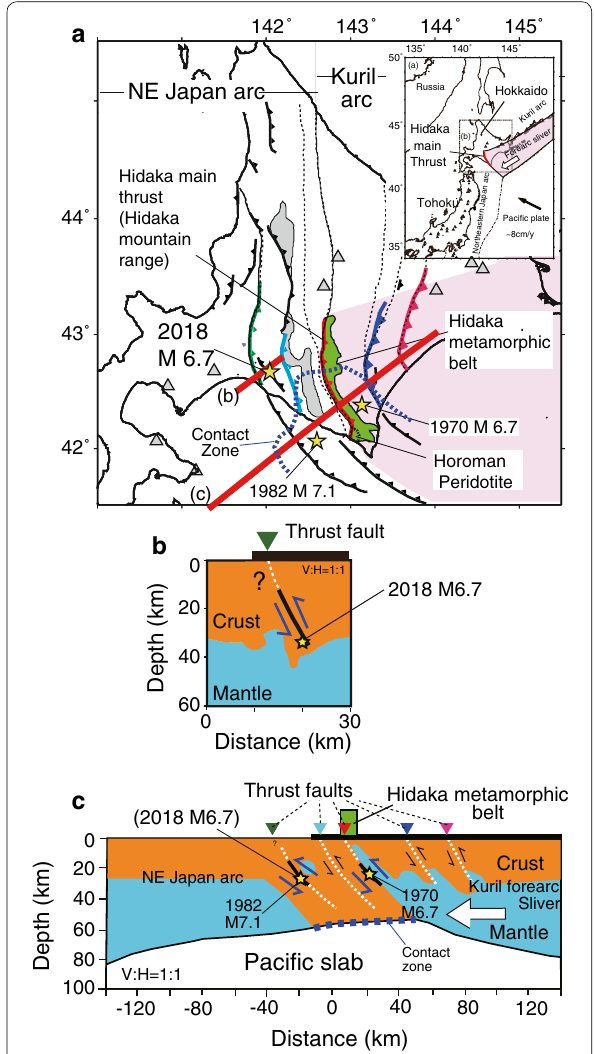
Fig. 1 a Tectonic setting of Hokkaido (modified after Kita et al. (2012), originally from Iwasaki et al. (2004), and Kimura (1994), and the Geological Survey of Japan 1992). The main plot is an enlarged image of the squared area in the inset map. The pink zone indicates the Kuril forearc. Dotted lines indicate tectonic boundaries. Thick lines with triangles denote Quaternary and Neogene thrust faults (green: Ishikari-teichi-toen fault zone; thin blue: Yubari-dake fault (Ito 2000); red: Hidaka main thrust; blue: Tokachi Plain faults: purple: Urahoro fault; black: other thrust faults). Green- and gray-shaded zones indicate the Hidaka metamorphic belt and the Kamuikotan metamorphic belt, respectively. Yellow stars indicate relocated hypocenters in the present study. Black stars indicate the hypocenters of the 1970 Hidaka and 1982 Urakawa-oki earthquakes. Triangles indicate sites of active volcanoes. The blue dashed line shows the location of the contact zone of the slab upper surface (Kita et al. 2010) with the anomalously deepened crustal materials. b Schematic diagram of the 2018 M6.7 event and the structure beneath south-central Hokkaido. c Schematic diagram of large inland events and the structure of the collision between the Kuril and NE Japan forearcs beneath the Hidaka collision zone